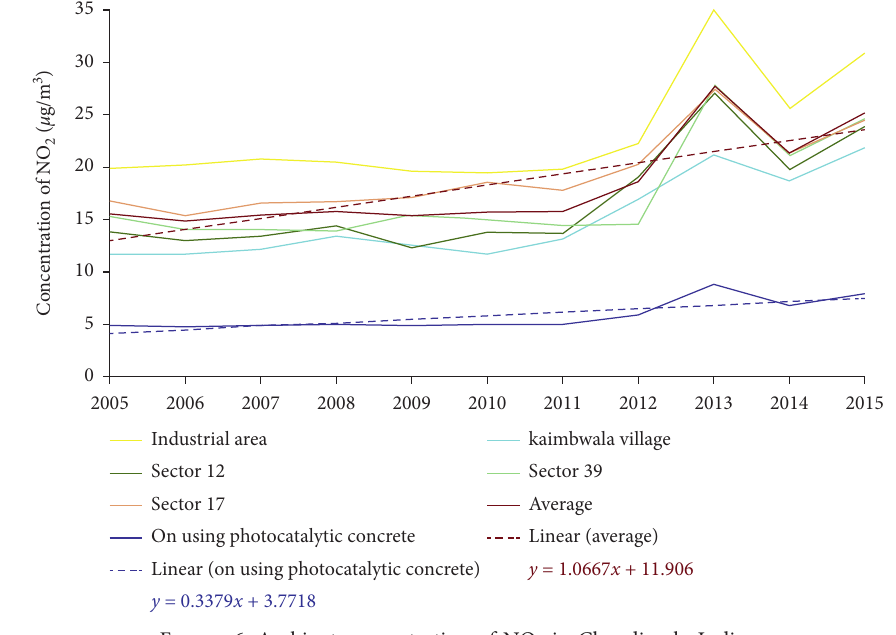
2 in Chandigarh, India.